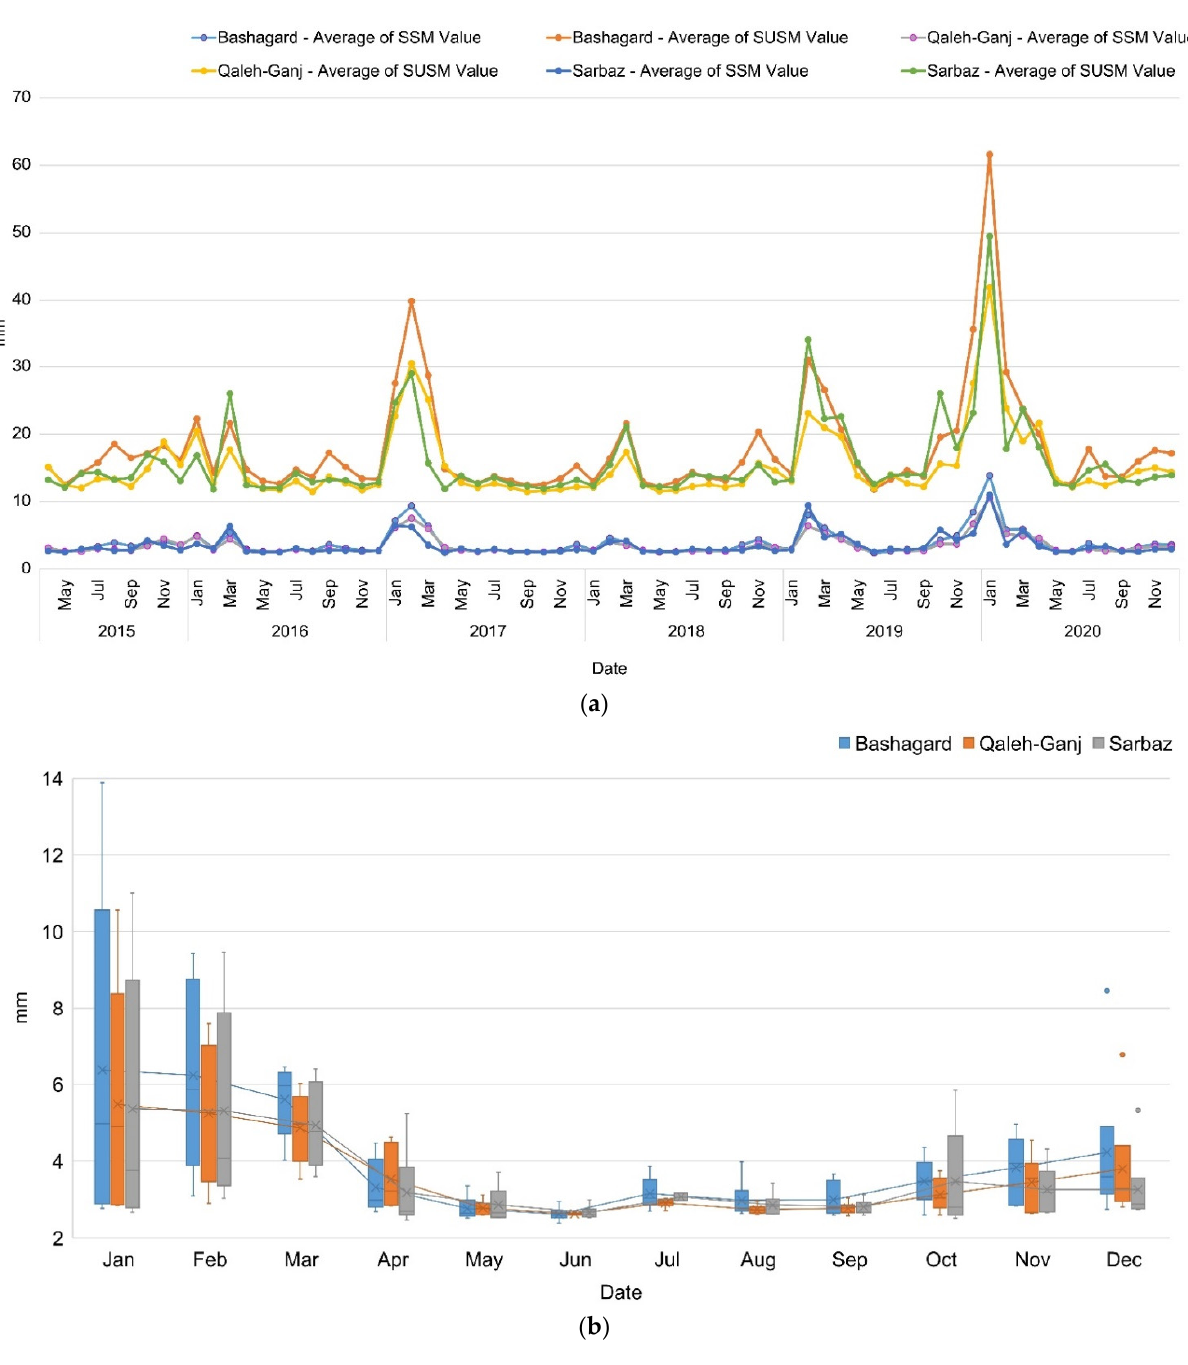
Figure 7. In this figure, soil moisture was generated in two forms of Surface Soil Moisture (SSM) and Subsurface Soil Moisture (SUSM) using the monthly averaging of NASA- USDA Enhanced SMAP time series data. Based on these results (Figure 6b), all three study areas exhibited the highest levels of SSM and SUSM from January to the end of April and October to the end of December. A short peak was seen in July, which may be related to summer rainfall.